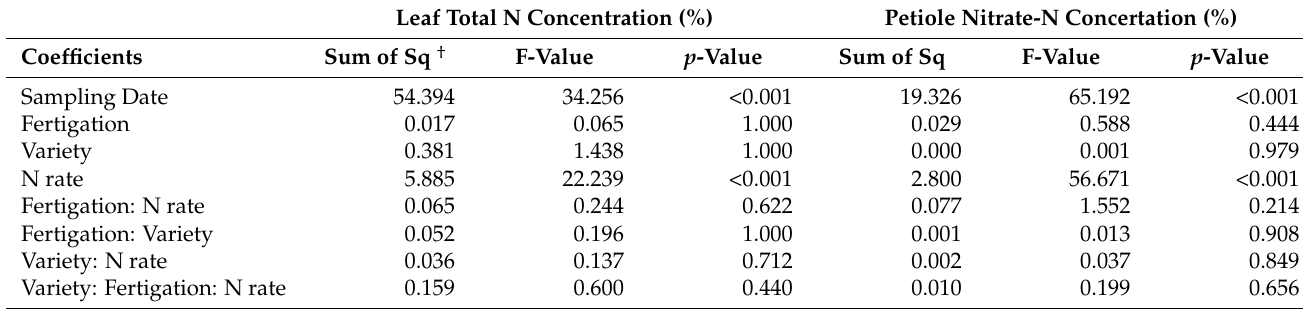
Table 3. Effects of the experimental factors on potato N concentrations.